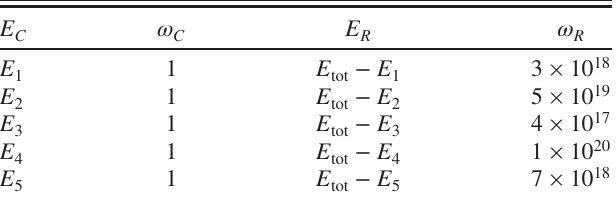
TABLE III. Sample energy and multiplicity values for the “ toy model ” system ( C ) and reservoir ( R ); see Fig. 1. This table was presented to students during the teaching interviews and is also used in the Boltzmann Factor tutorial. A key element of this situation is that the combined energy of C and R is a fixed value, E tot